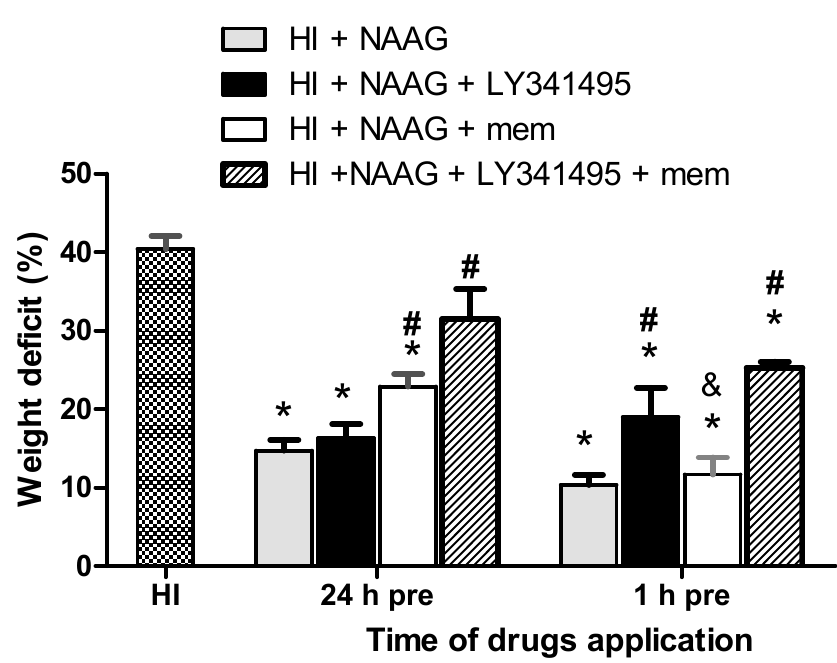
Figure 1. E ff ect of the application of group II mGluR antagonist LY341495 and NMDA receptor antagonist memantine (applied alone and in combination) on NAAG e ff ect on the weight deficit of the ipsilateral hemisphere after HI. All drugs were applied i.p. 24 or 1 h before HI insult. The weight deficit is expressed as the percentage of the weight of the contralateral (right) hemisphere. The results are presented as the means ± SEM, n = 4–9; * p < 0.001 compared to the HI group; # p > 0.01 compared to the HI + NAAG group; & p > 0.005 comparison between NAAG + memantine applied at two di ff erent times before HI.